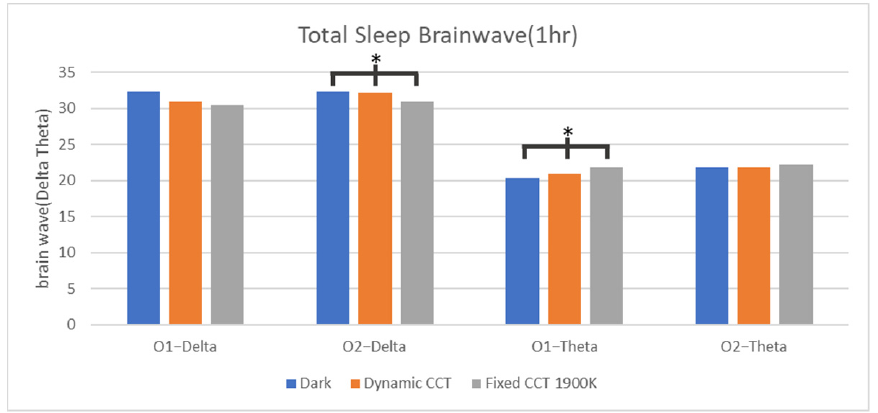
Figure 24. O1 and O2 energy distribution analysis (* p < 0.05).